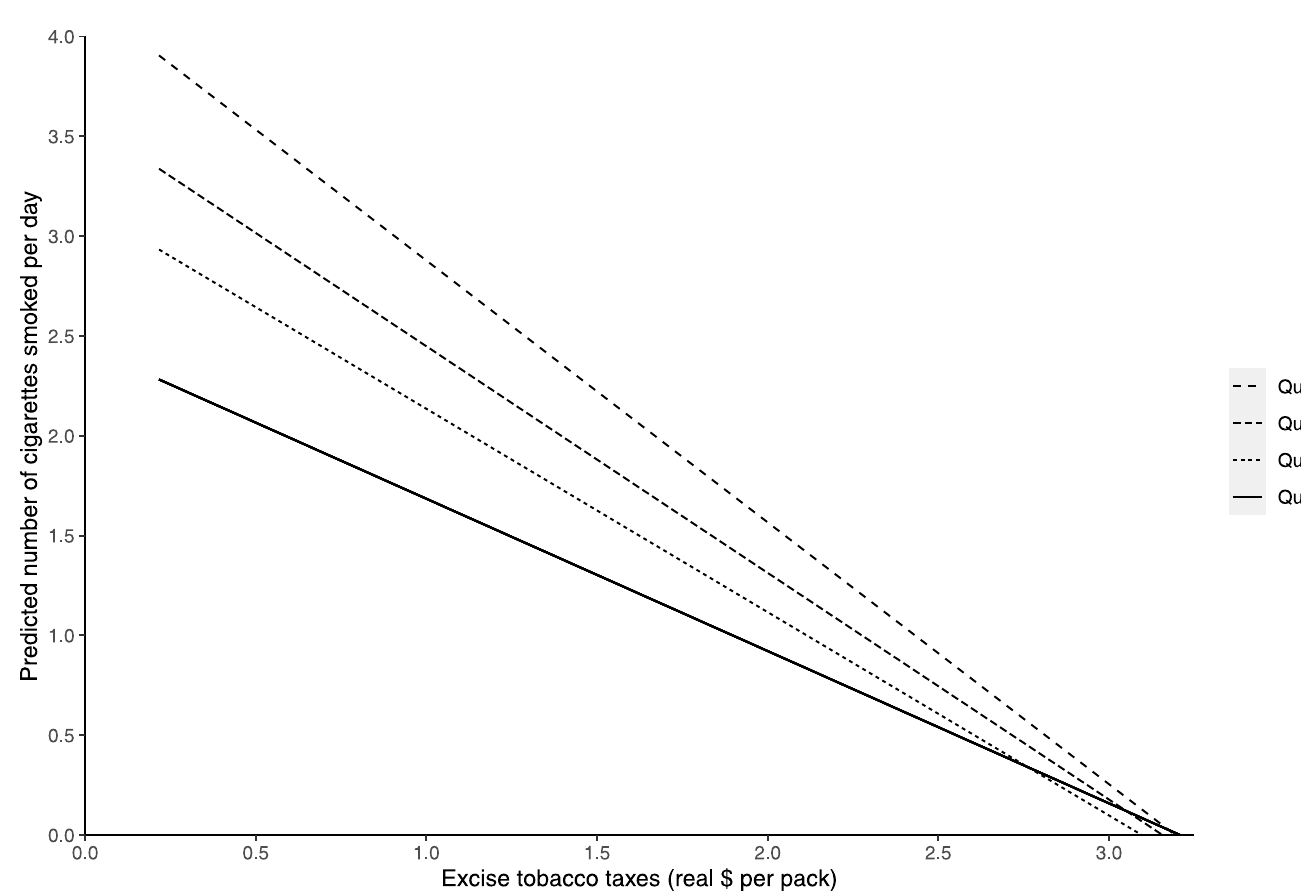
Fig 3. The relationship between excise tobacco taxes and the amount of tobacco consumption in each quartile of the distribution of the polygenic score for smoking intensity.